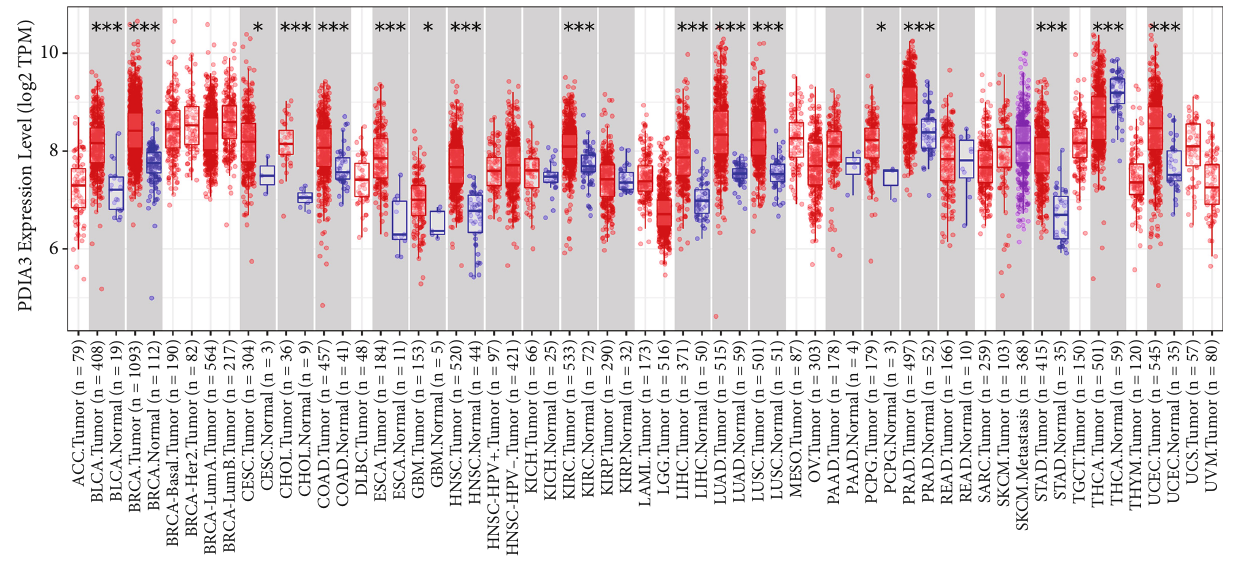
Figure 1: Expression of PDIA3 in various TCGA tumor tissues (* P < 0 : 05 , ** P < 0 : 01 , *** P < 0 : 001 ).